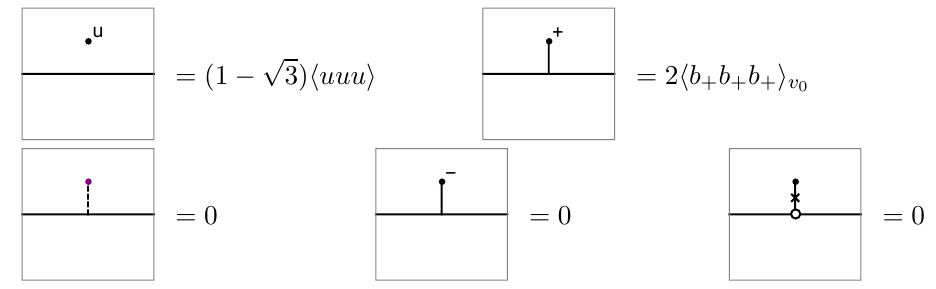
Figure 58 . Some torus one-point functions of defect operators.